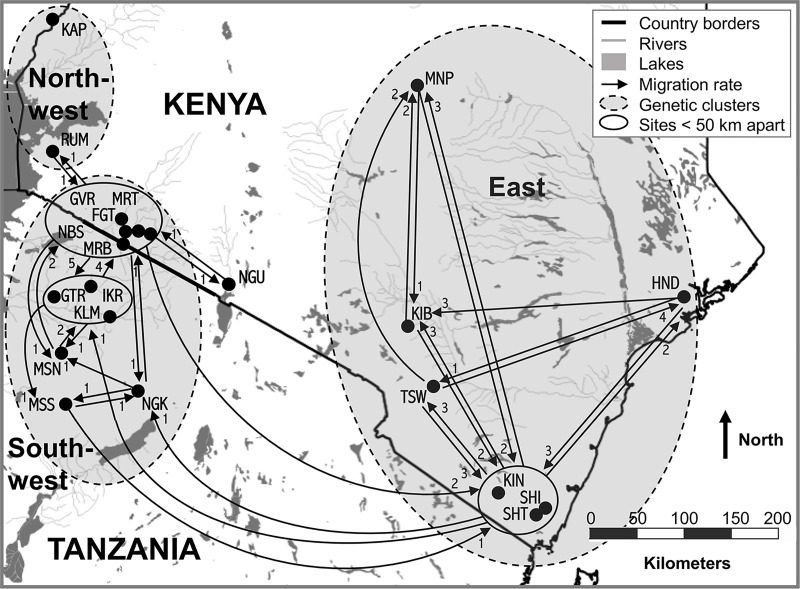
First generation migrants among sampling sites.Migrants detected using the software GENECLASS [70] indicated with arrows pointed in the direction of movement. Sites were grouped together if less than 50 km apart. Each dot represents a sampling site labeled with site codes (Table 1). The dashed outlines denote the three genetic clusters identified in BAPS v 6 [55,56]. The map was created in QGIS v2.12.1 (August 2017; http://qgis.osgeo.org) with free and publicly available data available from DIVA-GIS (August 2017; http://www.diva-gis.org).